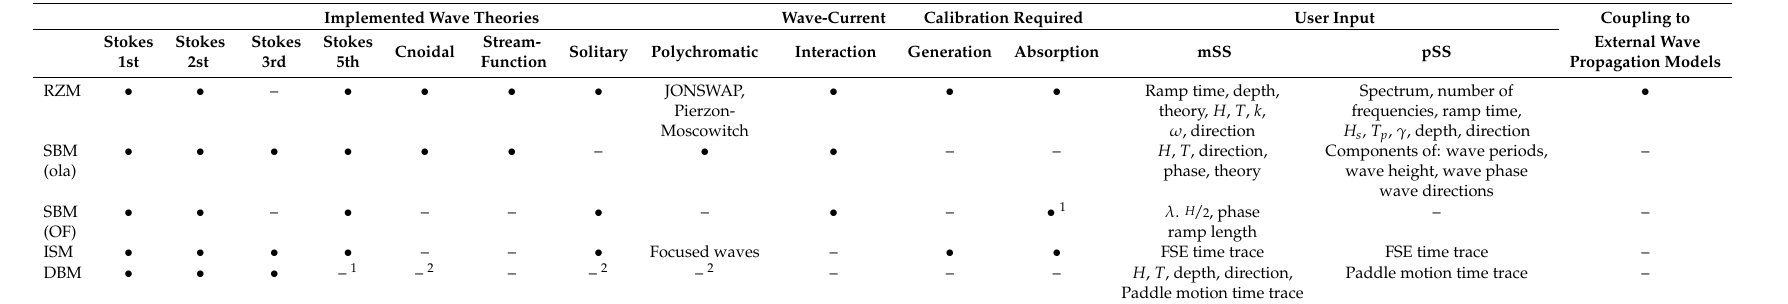
Table 18. Binary assessment of important NWM